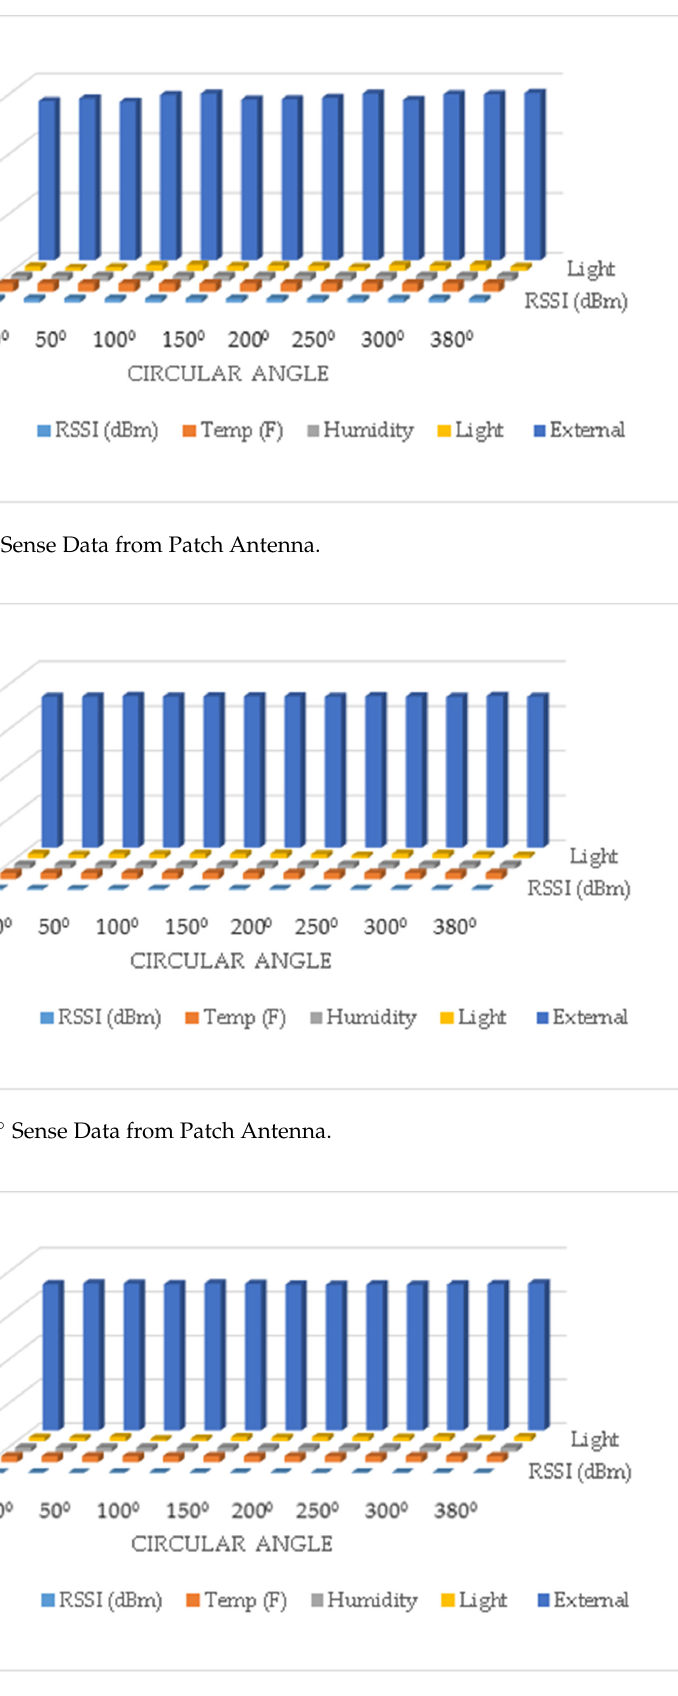
Figure 5. Sensor Device Placement for Patch Antenna.